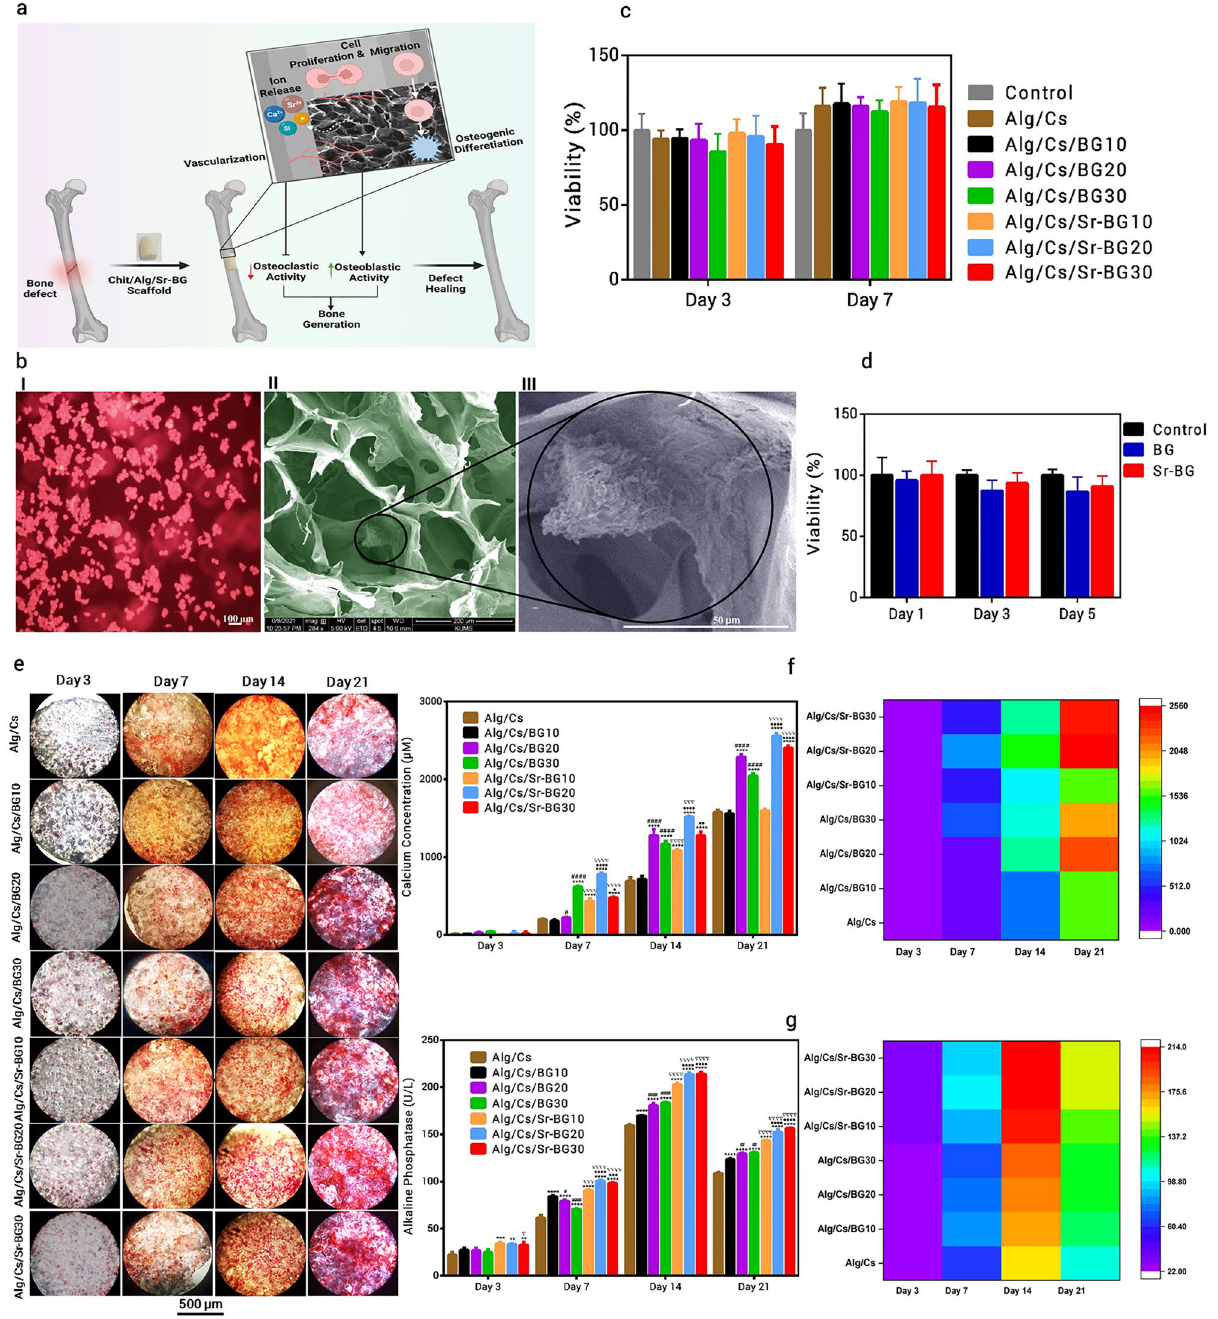
Figure 7. Potential clinical application and cellular studies results. ( a ) Potential clinical application, ( b ) Scaffold cell adhesion: (I)Florescence image, (II) SEM image and (III) Magnified SEM image, ( c ) Toxicity of scaffolds, ( d ) Bioglass toxicity, ( e ) Alizarin red staining of scaffolds, ( f ) Calcium content of scaffolds, ( g ) Alkaline phosphatase activity of scaffolds, Significant difference with Alg/Cs group at p < 0.01 (**), p < 0.001 (***), p < 0.0001 (****). Significant difference with Alg/Cs/BG10 group at p < 0.05 ( # ), p < 0.01 ( ## ), p < 0.0001 ( #### ). Significant difference with Alg/Cs/Sr-BG10 group at p < 0.05 ( · ), p < 0.01 ( ·· ), p < 0.001 ( ··· ), p < 0.0001 ( ···· ). Significant difference between Alg/Cs/BG and Alg/Cs/Sr-BG groups at p < 0.05 ( ⛛ ), p < 0.001 ( ⛛⛛⛛ ), p < 0.0001 ( ▽▽▽▽